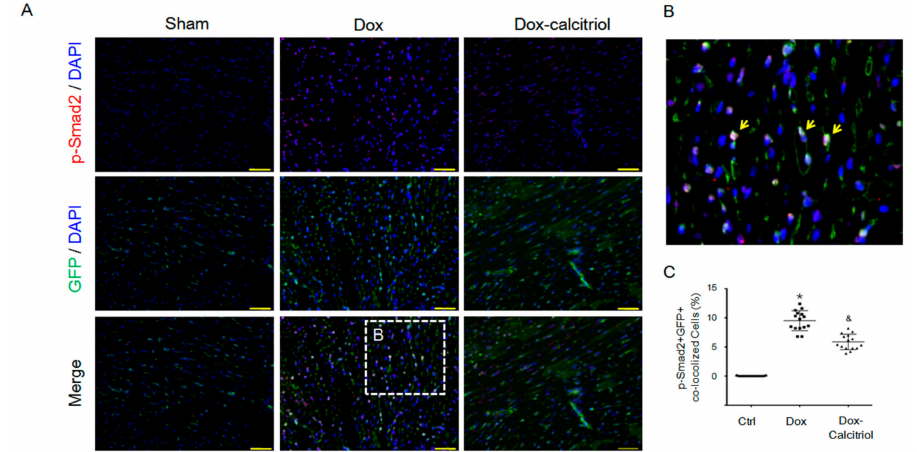
Figure 5. Calcitriol-attenuated doxorubicin-induced Smad2 activation in vivo. ( A ) Representative photomicrographs of double immunofluorescence staining antibodies with p-Smad2 (red) and GFP (green) in di ff erent groups. ( B ) Enlarged area from ( A , white box). The yellow arrows indicated p-Smad2 + co-localized in GFP + cells. ( C ) Quantification of p-Smad2 +/ GFP + cells per visual field in the Ctrl, Dox, and Dox–calcitriol groups. N = 3 mice per group (5 high power field (HPFs) per mouse, 15 HPFs total). Scale bar: 200 µ m. Experiments were conducted in triplicate. Data are expressed as mean ± SEM, and n represents the number of animals. * p < 0.05 vs. Ctrl, & p < 0.05 vs.